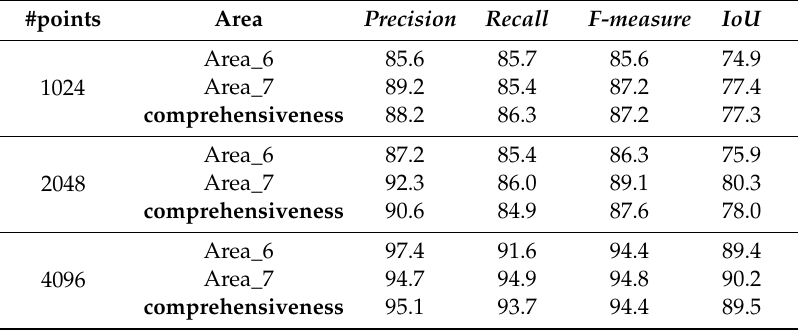
Table 4. A comparison between training with di ff erent sample sizes.